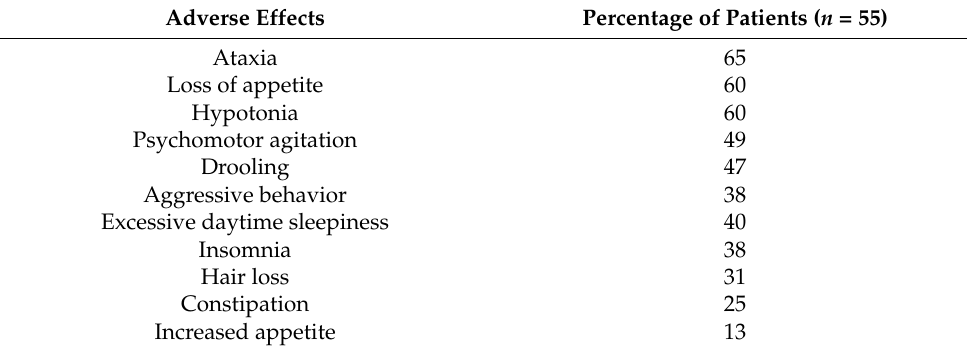
Table 2. Adverse effects during the antiepileptic